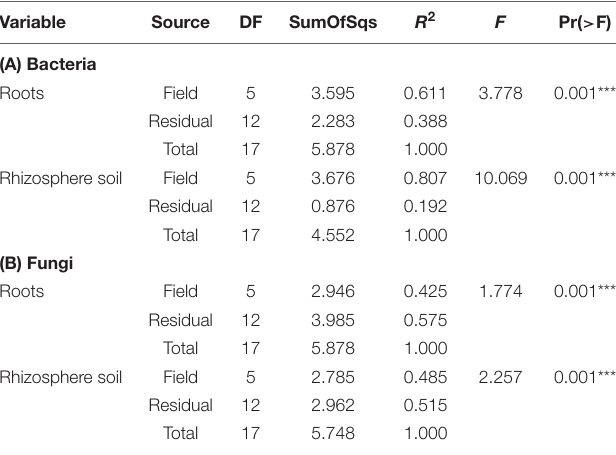
TABLE 2 | Effect of fields on the structure of the bacterial and fungal communities in root and rhizosphere soil according to PERMANOVA. Variable Source DF SumOfSqs R